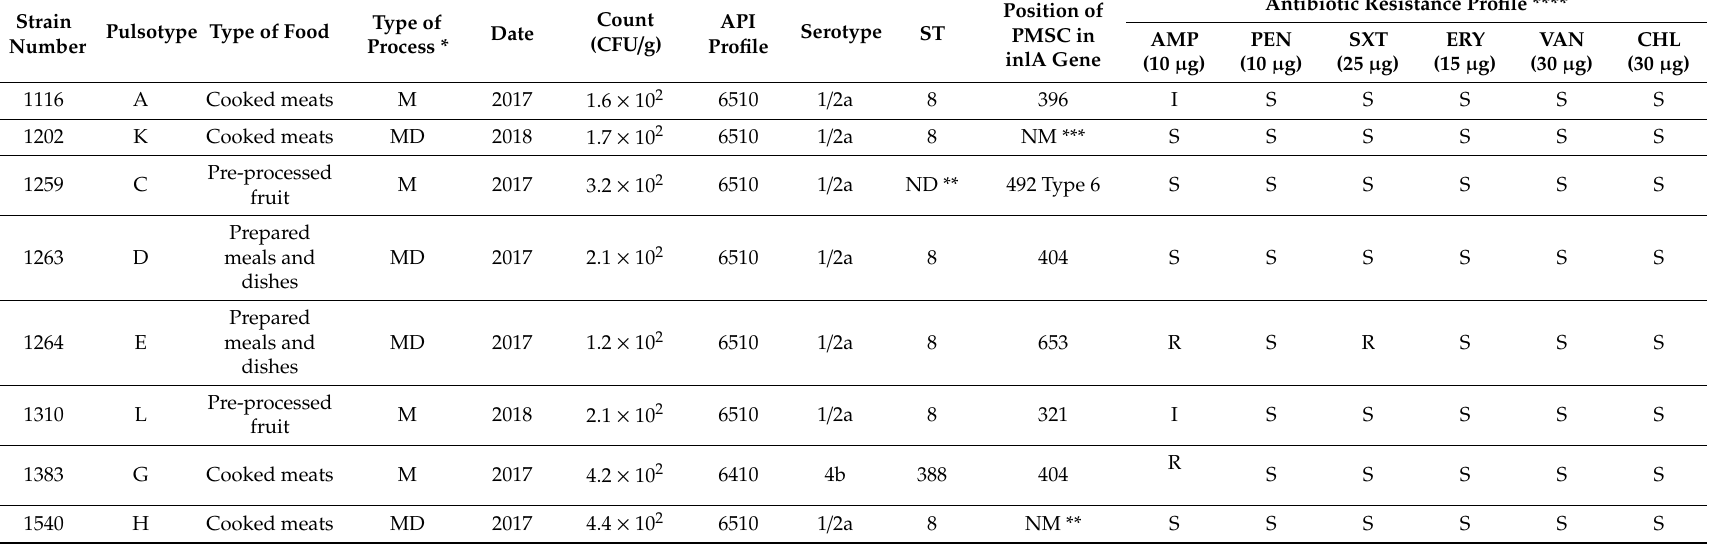
Table 3. Characteristics of strains isolated in food according to genotype, type of food, type of process, API profile, serotype, sequence type (ST), premature stop codons (PMSC), and antibiotic resistance